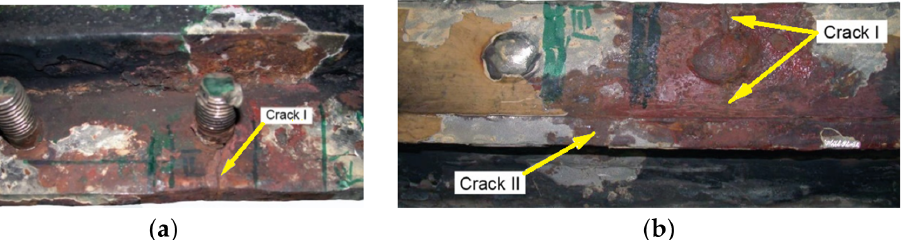
Figure 27. Macroscopic examination (handy-size bulk carrier 30210 DWT): ( a ) view of crack I, ( b ) view of crack II (crack I is visible on the right-hand side).